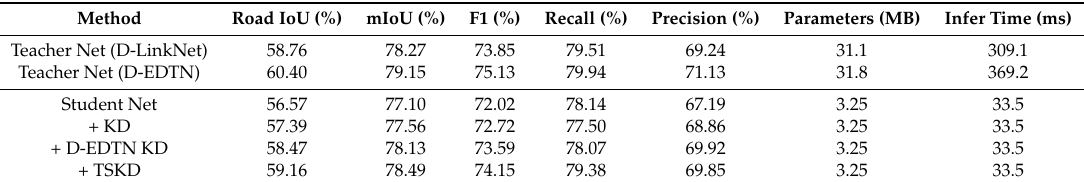
Table 1. Performance comparisons of student nets based on knowledge distillation of the Massachusetts Dataset in terms of Road IoU, mIoU, F1 score, recall, precision, parameters, and inference time (Infer Time). The best results are shown in bold.